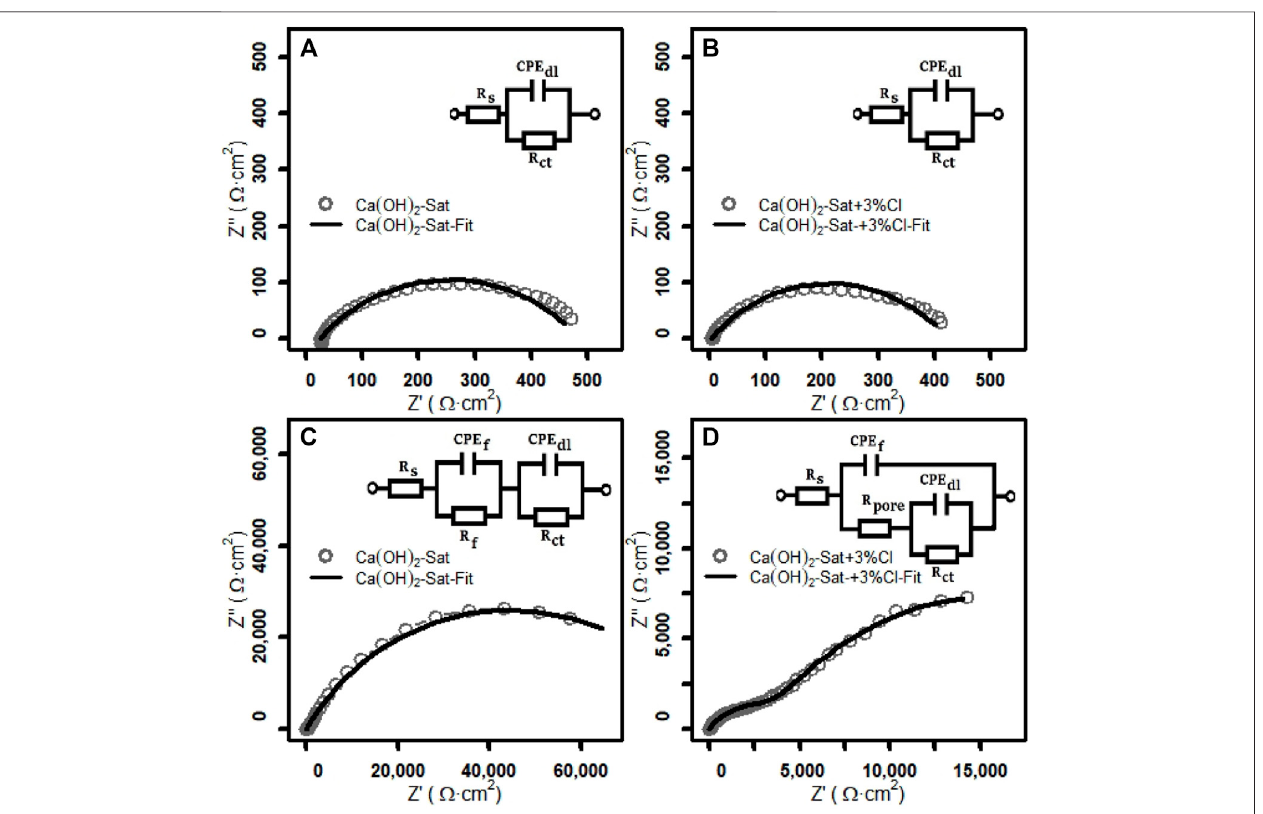
FIGURE 6 | Nyquist spectrum of the Z fi t analysis of zinc plates in the two test solutions: before the sudden rise in the E corr (A) without chlorides and (B) with chlorides, and after the sudden rise in the E corr (C) without chlorides and (D) with chlorides.